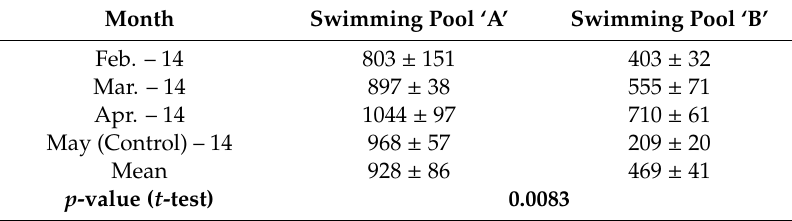
Table 3. Mean and p -values of conductivity levels in the swimming pools in the Tamale Metropolis.